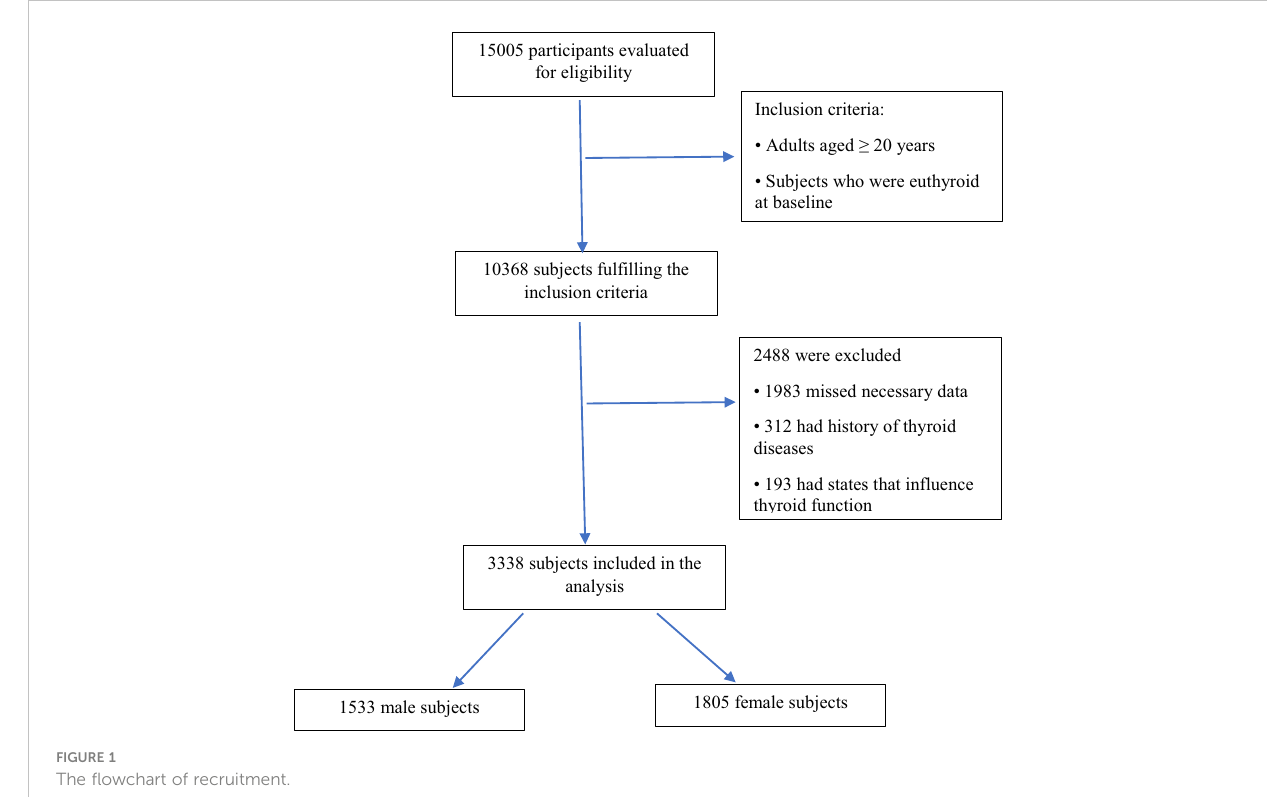
FIGURE 1 The fl owchart of